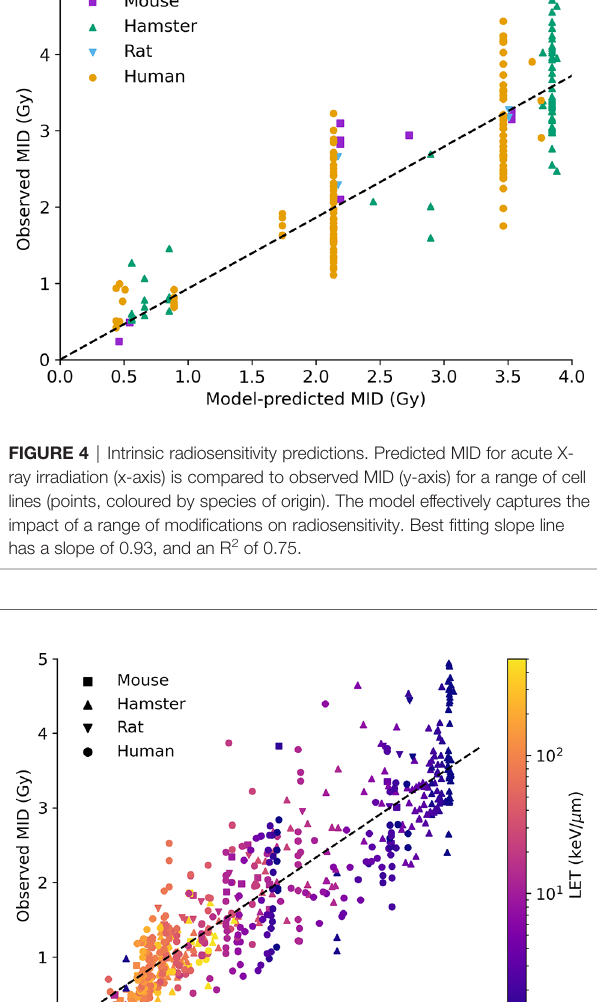
(dashed line, <0.1 Gy/hr dose rate) exposures. It can be seen that